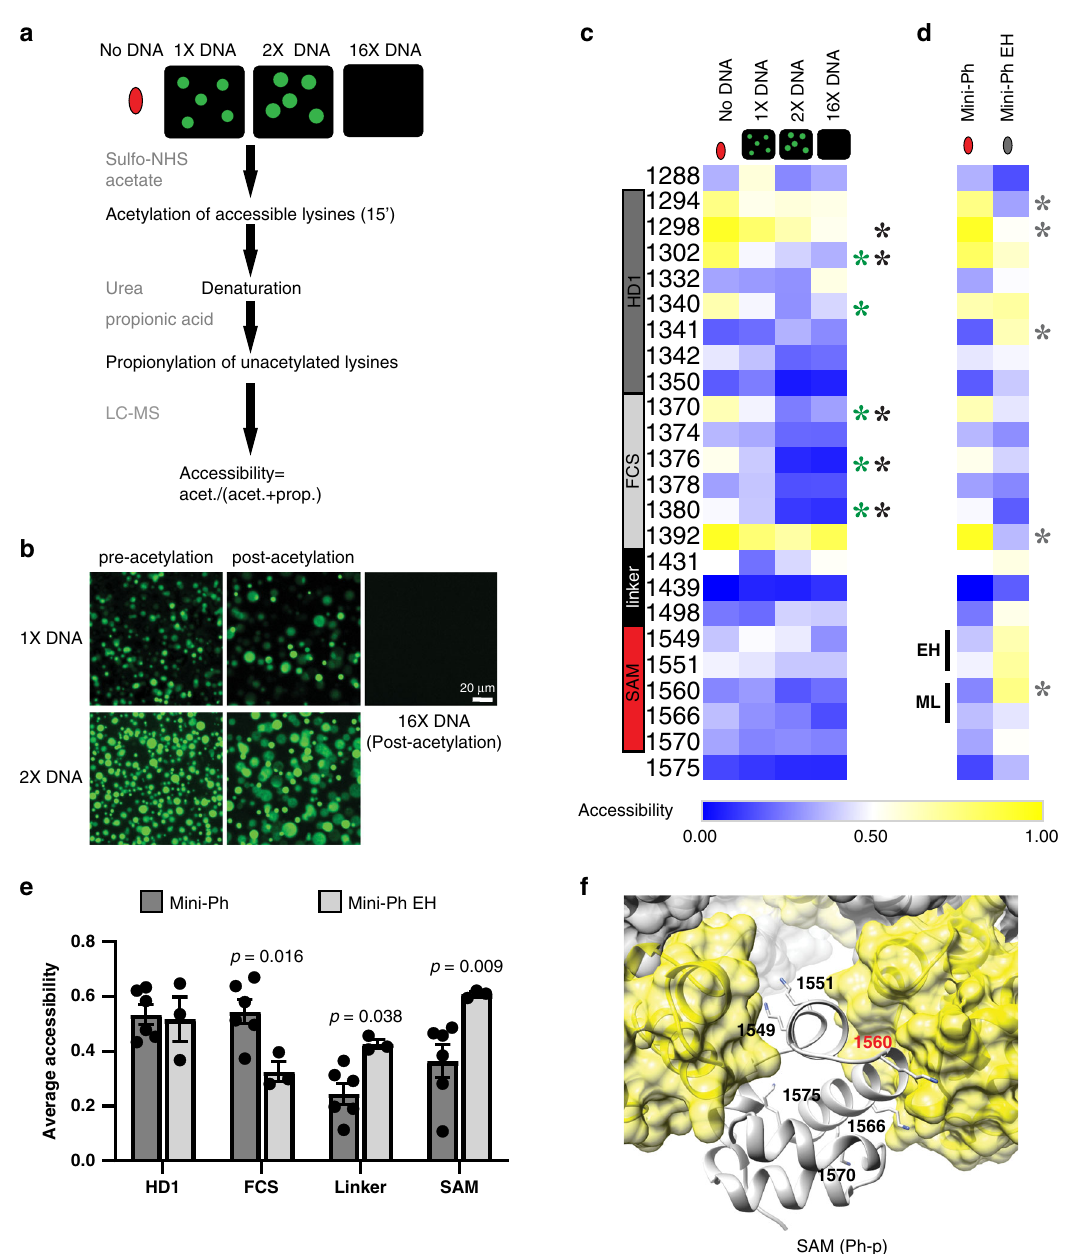
Fig. 4 Lysine accessibility in Mini-Ph-DNA condensates. a Schematic of lysine-footprinting assay. Mini-Ph or Mini-Ph EH alone, or in the presence of 1×, 2×, or 16× DNA, is treated with sulfo-NHS acetate to acetylate-accessible lysines. The protein is denatured and treated with propionic acid to propionylate unacetylated lysines. Samples are processed for mass spectrometry, and accessibility is quanti fi ed as fraction acetylated for each lysine position (Eq. (3)). b Mini-Ph-DNA condensates before and after 15 min of acetylation reaction. c Heat map showing accessibility for Mini-Ph alone or with the indicated